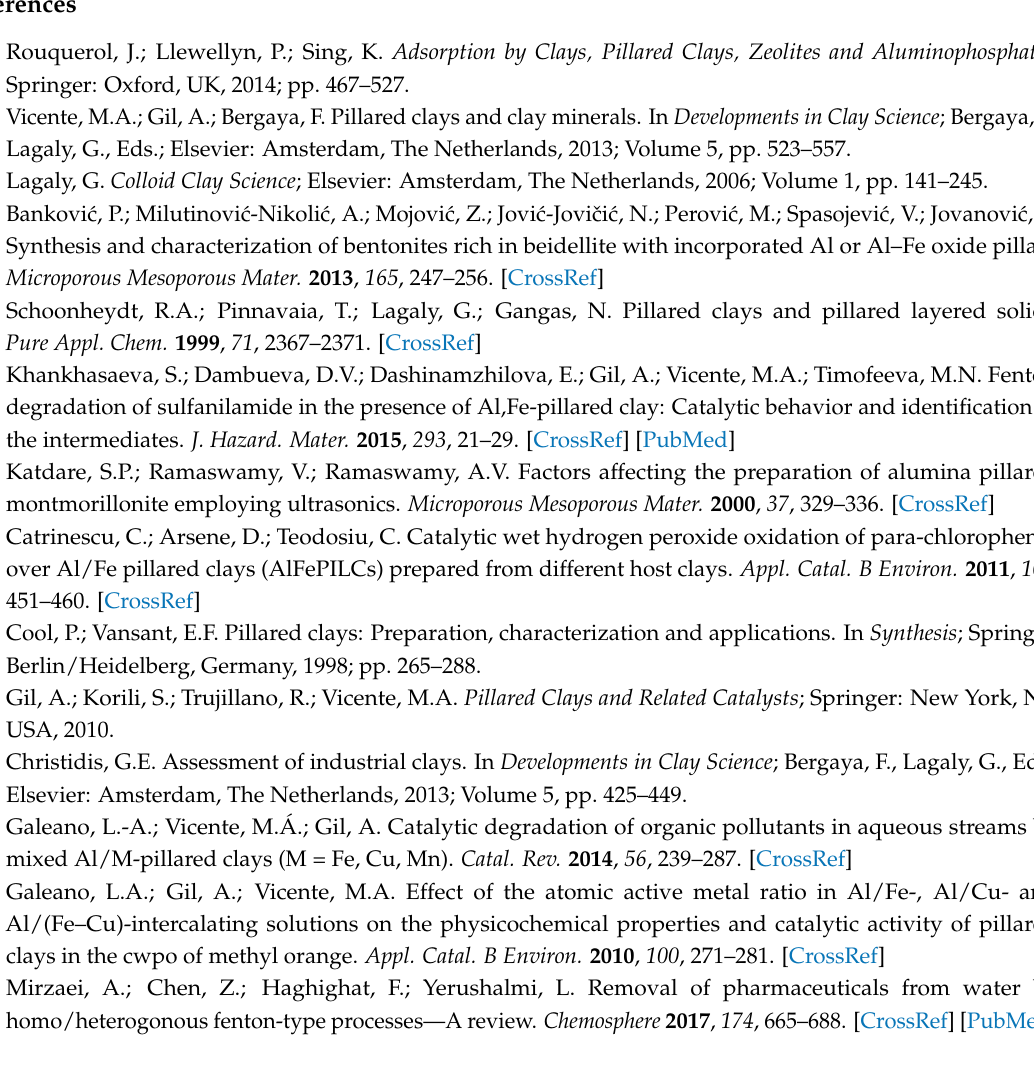
Figure S1: X-ray diffraction patterns of raw minerals in oriented films: (a) C1, (b) C3 and (c) BV, under following conditions: (1) untreated, (2) Ca 2+ –homoionized, (3) saturated with ethylene glycol and (4) calcined at 400 ◦ C/2 h, Figure S2: Nitrogen adsorption-desorption isotherms of refined and pillared forms of C1 and C3 clays, Figure S3: Hydrogen–temperature programmed reduction (H 2 –TPR) diagrams of refined (R) and pillared forms of clays C1 and BV. Acknowledgments: The financial support from Proyecto Agua Potable Nariño (BPIN 2014000100020), CT&I